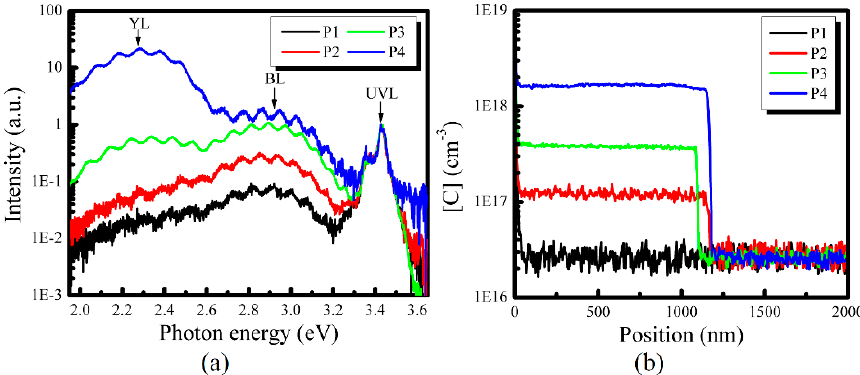
Figure 3. ( a ) Room-temperature PL spectra of u-GaN samples P1–P4 grown under different pressure, and ( b ) the carbon distribution profile. The arrows indicate the main luminescence bands.